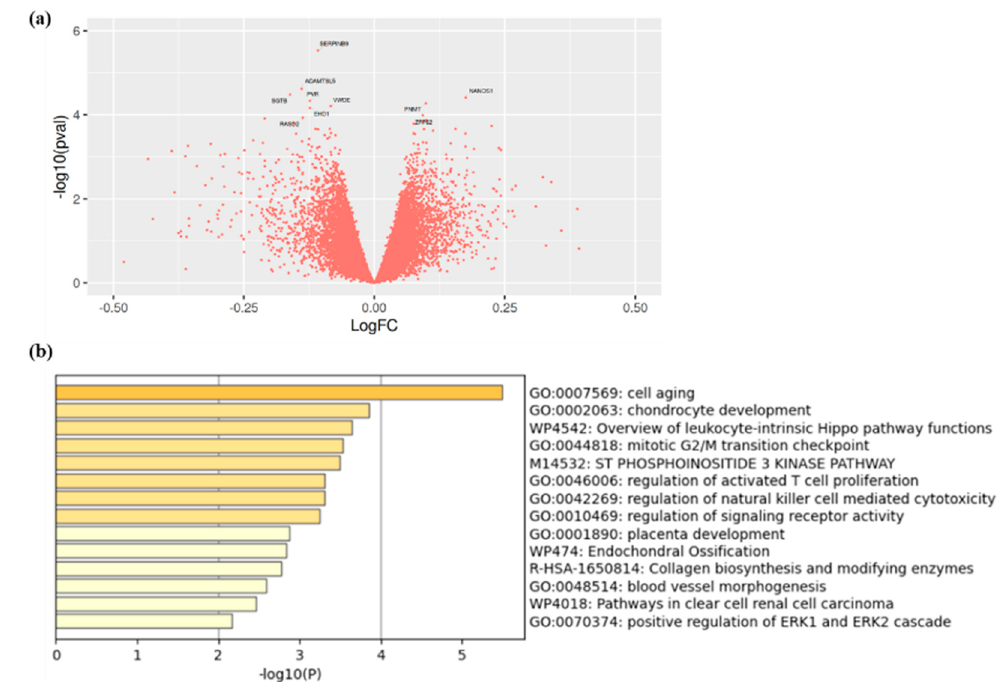
Figure 2. ( a ) Volcano plot showing the genes identified in calcified valve of patients with high versus low Lp(a) and ( b ) enrichment analysis of genes found to be the most influenced by Lp(a) concentrations in explanted calcified aortic valves of patients with high versus low Lp(a).